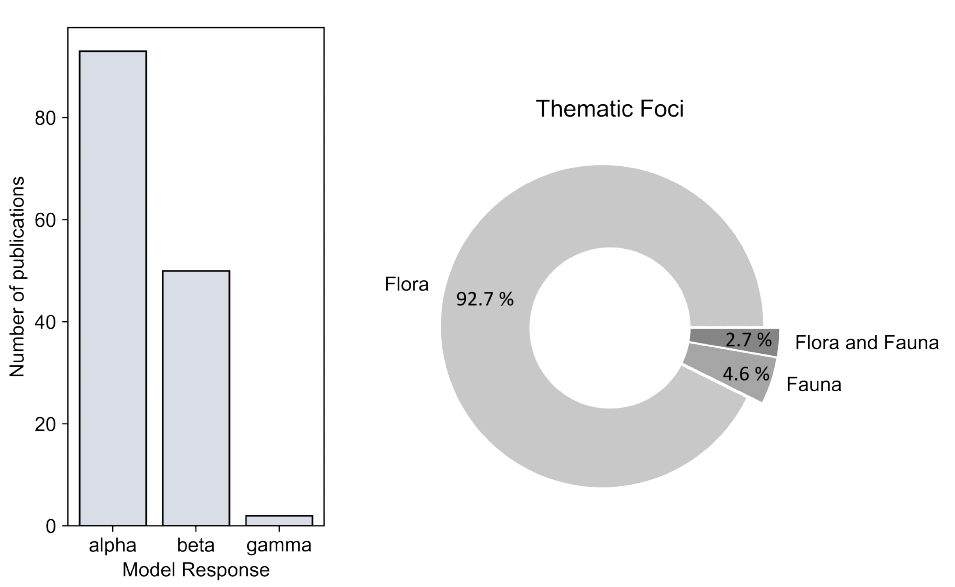
Figure 12. Analysis of the different model responses ( α , β , γ diversity) and environmental foci (flora,